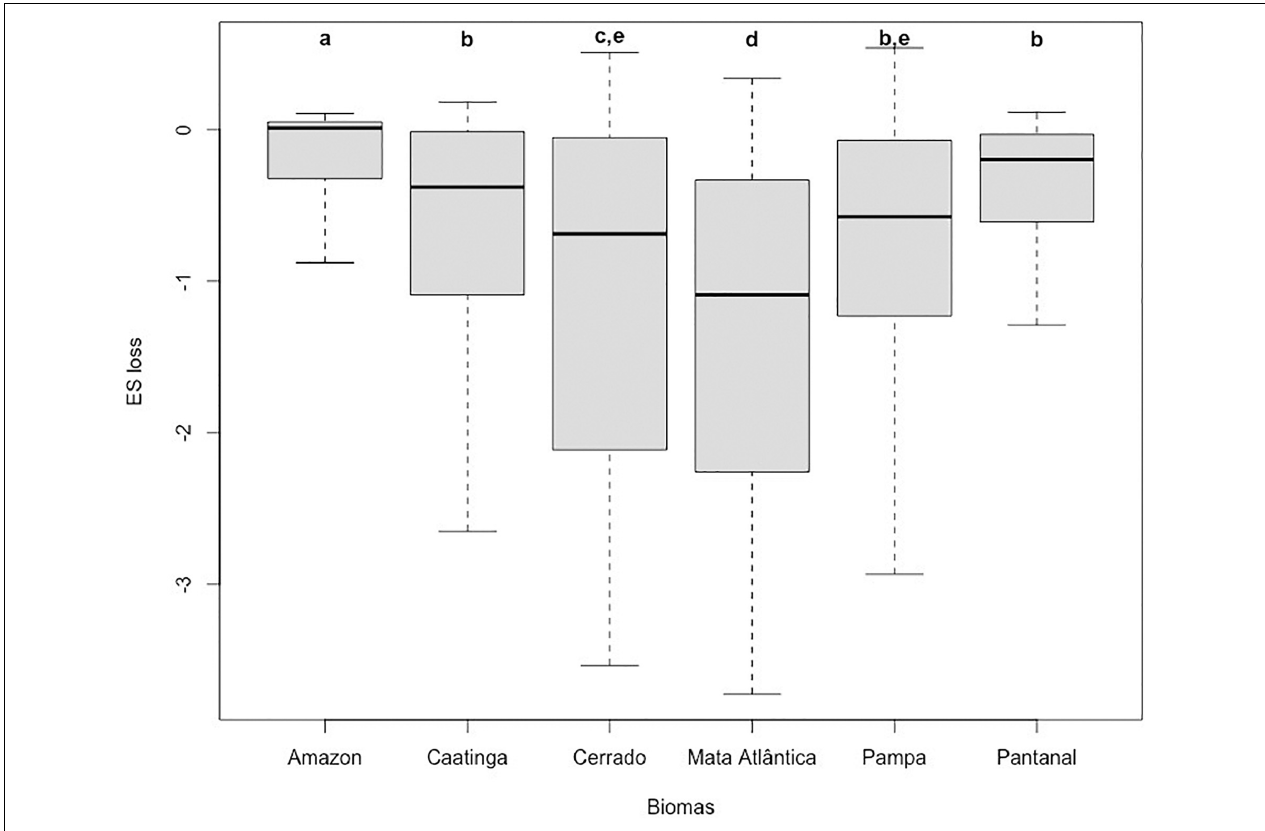
FIGURE 3 | Loss of ecosystem services (ES) per biome and between biome differences. Significance is related to the post hoc pair-wise comparison test ( p < 0.05).